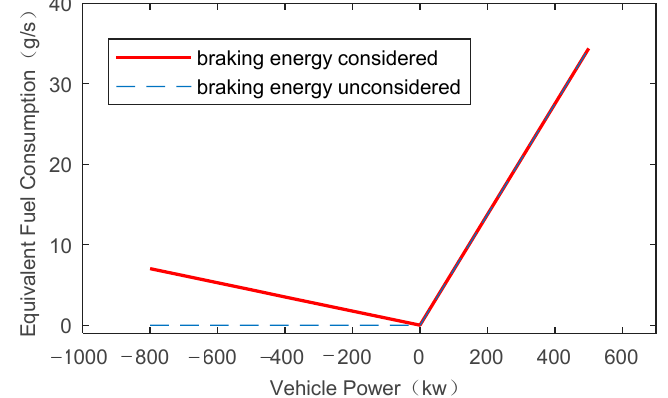
Figure 3. Simulated EFC models.